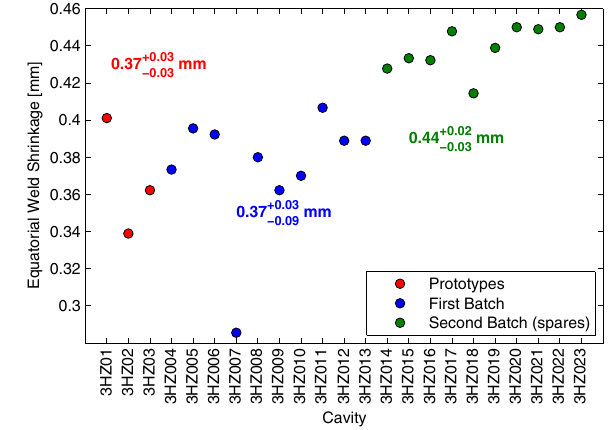
FIG. 5. Equatorial weld shrinkage (per weld seam) experience in the three production batches of the 3.9 GHz EXFEL cavities. In the labels the averages and uncertainties of each data